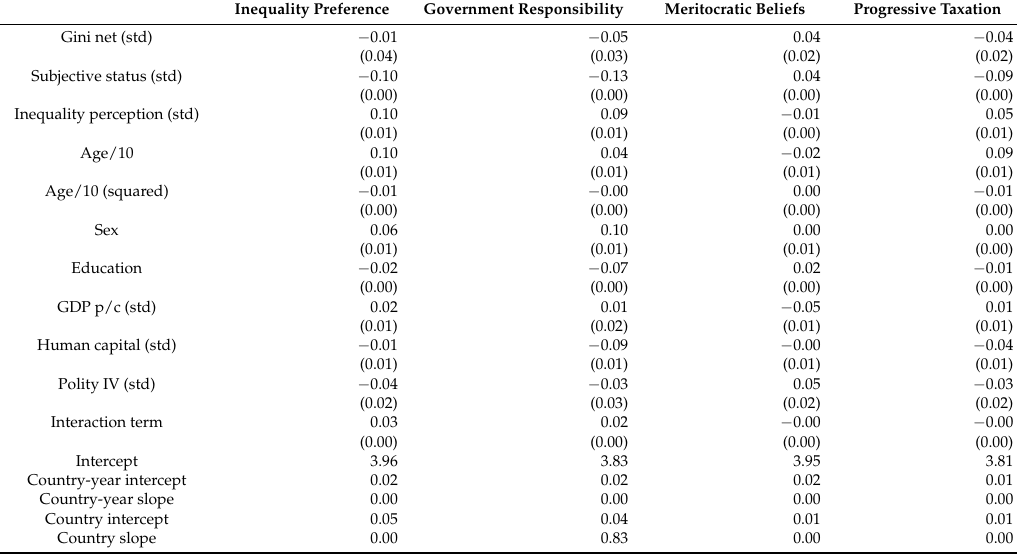
Table A1. Regression tables from varying-intercept, varying-slope models of political